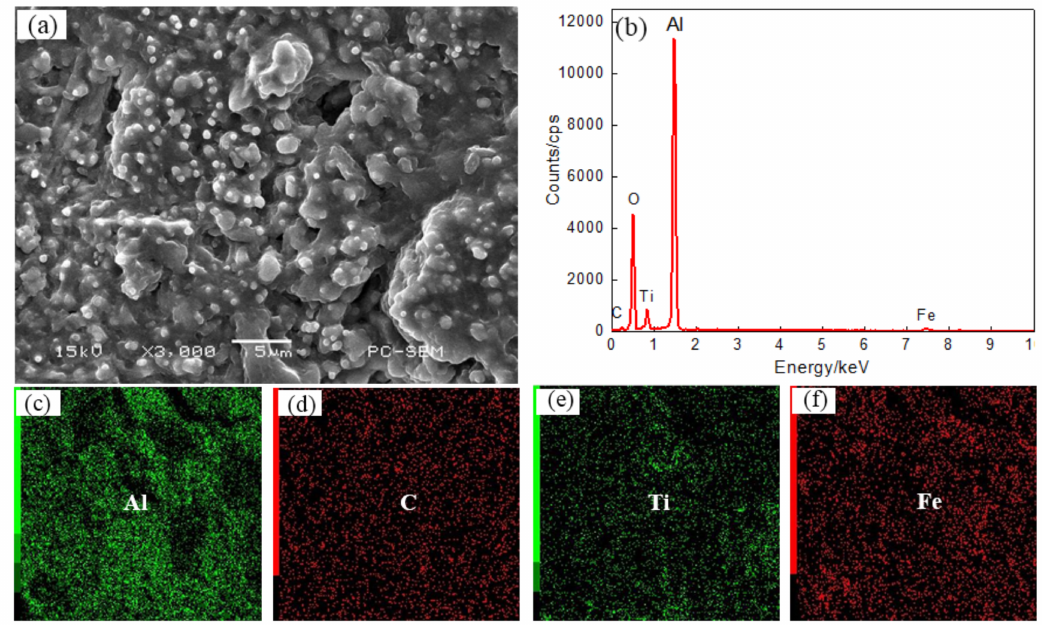
Figure 9. The surface SEM images ( a ) and EDS analysis result ( b ) and element content of Plane scan (( c ) Al content ( d ) C content ( e ) Ti content ( f ) Fe content) of Coating